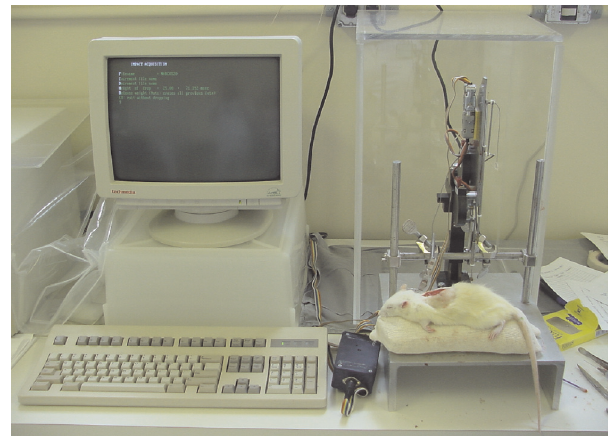
Figure 2 - NYU system